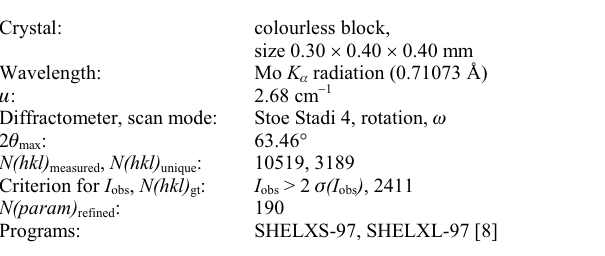
Table 1. Data collection and handling.